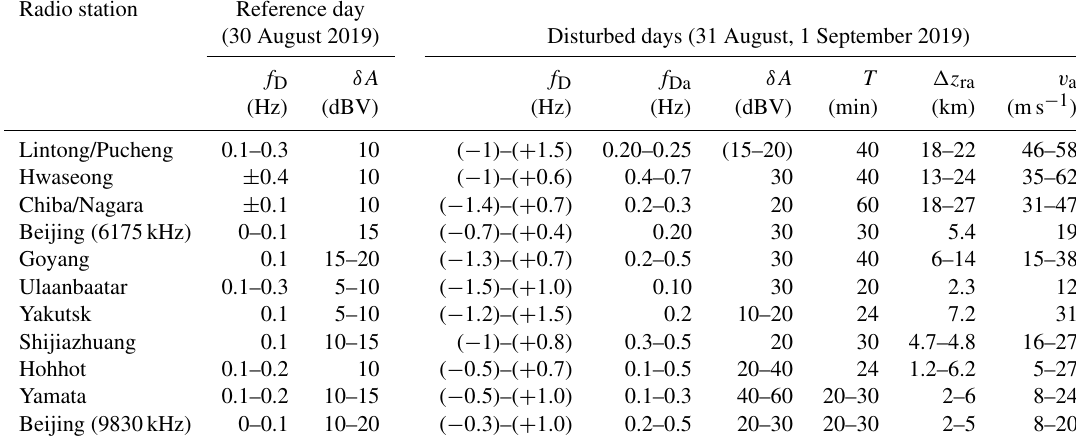
Table 2. Aperiodic variations in the signal amplitude, δA , and aperiodic and quasi-periodic variations in the Doppler shift of frequency, together with f D , with amplitude f Da and period T , and the amplitudes of variations in the level of reflection, (cid:49)z ra , and in the speed of the level of reflection, v a